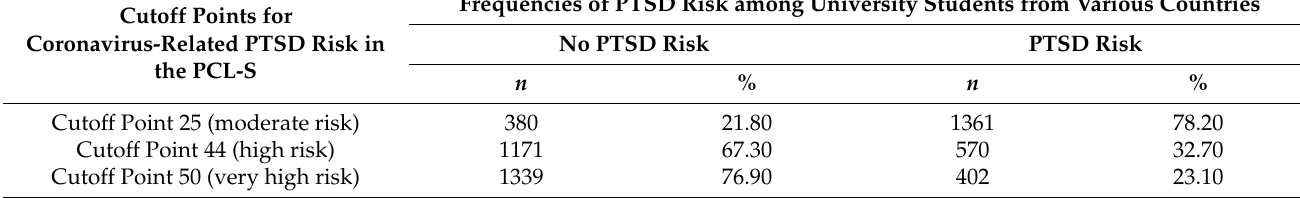
Table 4. Prevalence of coronavirus-related PTSD risk among university students in six countries during the second wave (October–December 2020) of the COVID-19 pandemic ( N = 1741). Cutoff Points for Coronavirus-Related PTSD Risk